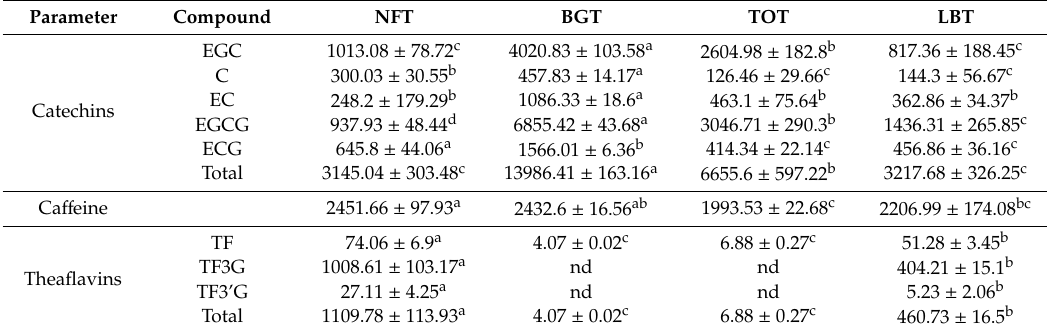
Table 4. Catechins, ca ff eine, and theaflavins contents in di ff erent tea samples (mg / 100